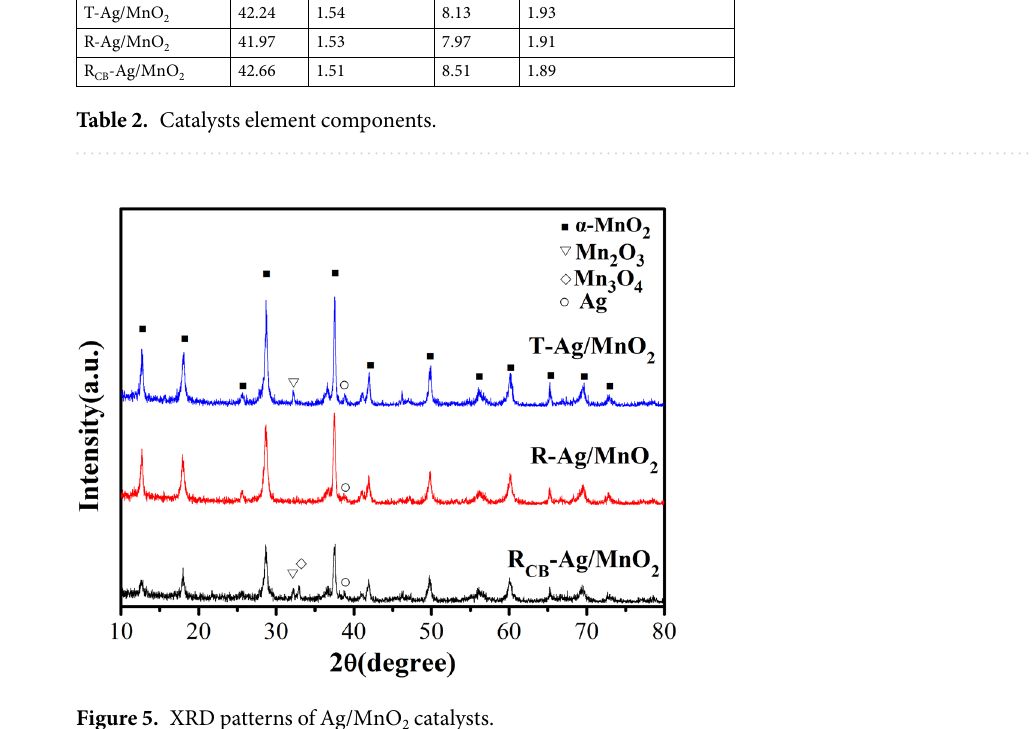
Figure 5. XRD patterns of Ag/MnO 2